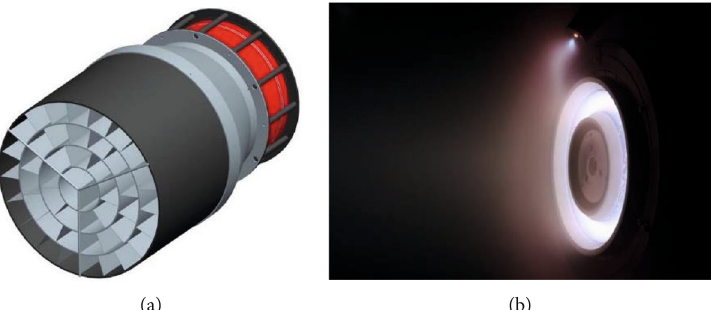
Figure 18: Andreussi ’ s RAM-HET: (a) view of the intake/collector assembly reduced scale mode; (b) HT5k fi ring with 1.27N mixture